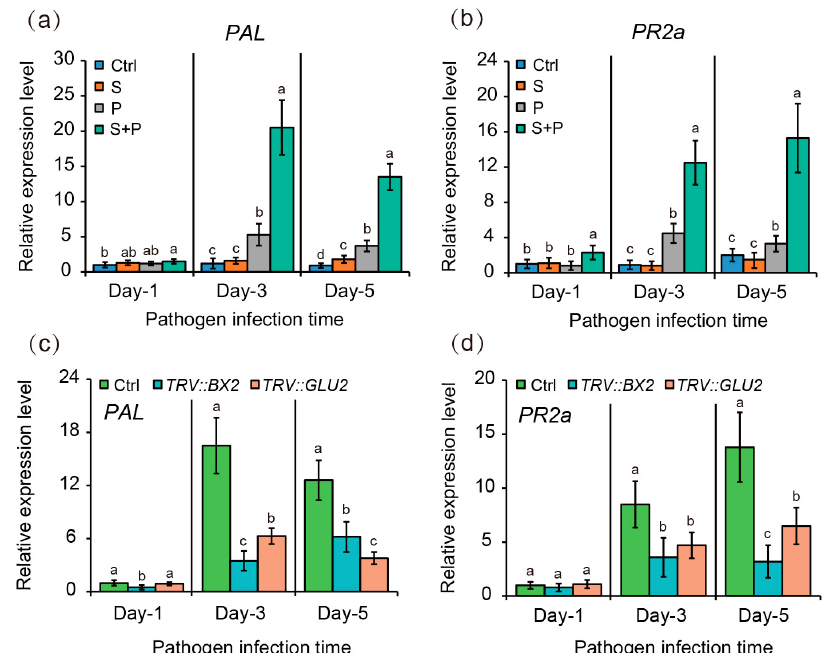
Figure 5. qPCR analyses of two defense-related marker genes PAL and PR2a in the leaves of maize plants. Four-week-old maize seedlings were inoculated with or without bacterial suspensions of MZ05 (1 × 10 8 CFU / g soil). After 7 days of inoculation, these plants were treated with the fungal pathogen S. turcica at 5 × 10 4 conidia mL − 1 . After di ff erent time points (1, 3, and 5 days) of pathogen infection, the fourth leaves were harvested for qPCR analyses of the PAL ( a ) and PR2a ( b ) transcripts in the pathogen-infected leaves. Ctrl, control plants without pathogen and MZ05 inoculation; S: plants treated with S. turcica ; P: plants inoculated with MZ05; S + P: plants inoculated with both S. turcica and MZ05. Moreover, the expression levels of PAL ( c ) and PR2a ( d ) in the pathogen-treated plants were investigated in the control (Ctrl), TRV::BX2 , and TRV::GLU2 plants exposed to MZ05. Di ff erent letters indicate statistically significant di ff erences among di ff erent groups using one-way analysis of variance and Ducan’s tests ( p < 0.05).